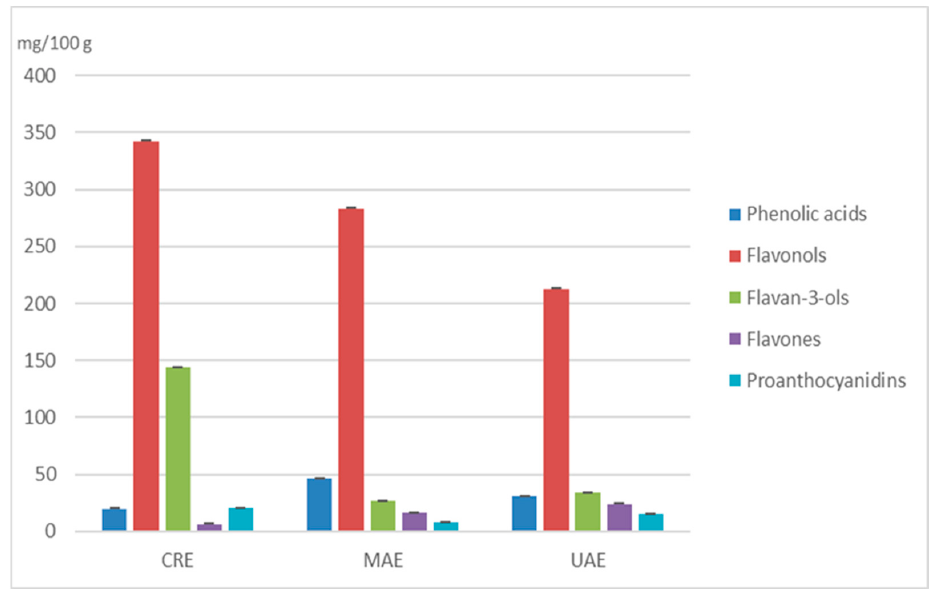
Figure 2. The content of different groups of polyphenolic compounds determined by UPLC-MS/MS in extracts obtained by CRE, MAE and UAE.